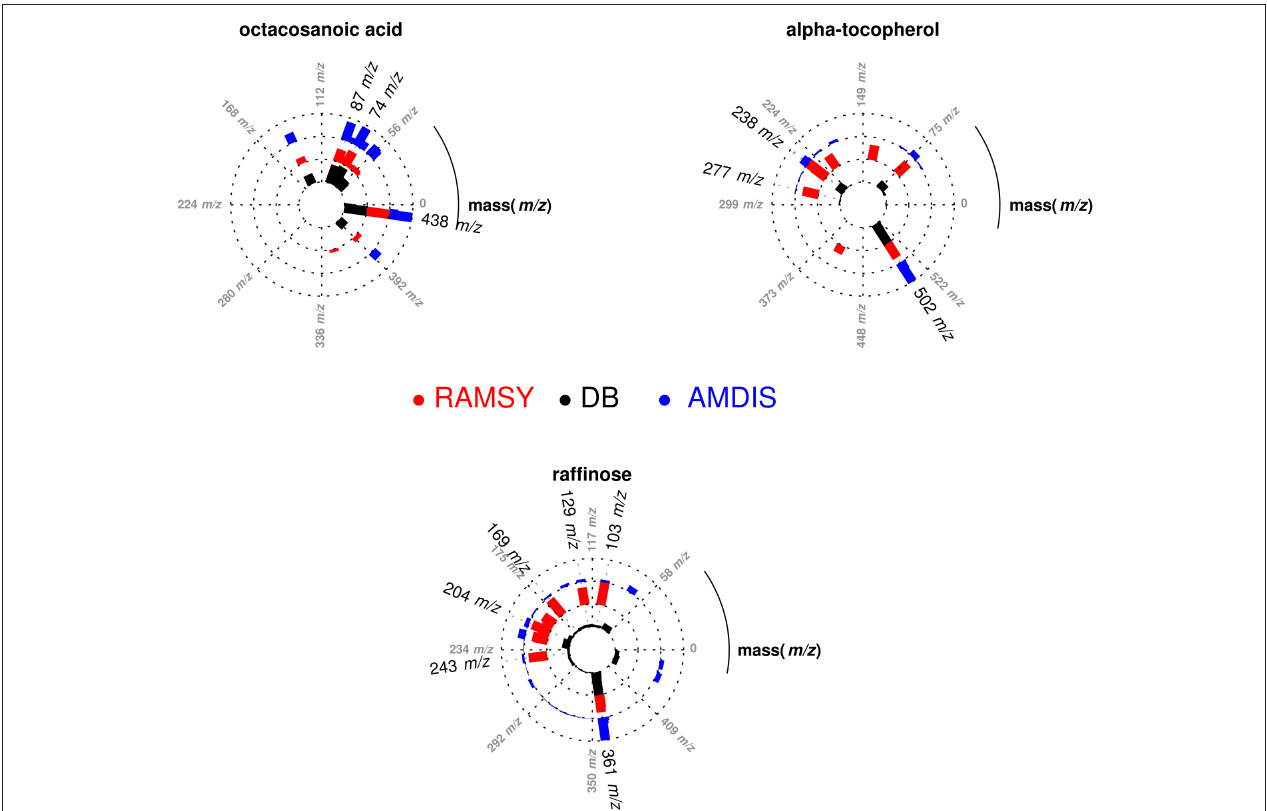
FIGURE 3 | Polar plot of “pure” MS spectra recovered from the co-eluted GC-MS peaks between 37.75 and 38.00 min. Each lane corresponds to the mass spectra obtained from AMDIS (blue), RAMSY (red) or database-DB (black). Octacosanoic acid (AMDIS MF 770 and RAMSY MF 870), α -tocopherol (AMDIS MF = = 500 and RAMSY MF 900) and raffinose (AMDIS MF 600 and RAMSY MF 900) were found using AMDIS and = = = =